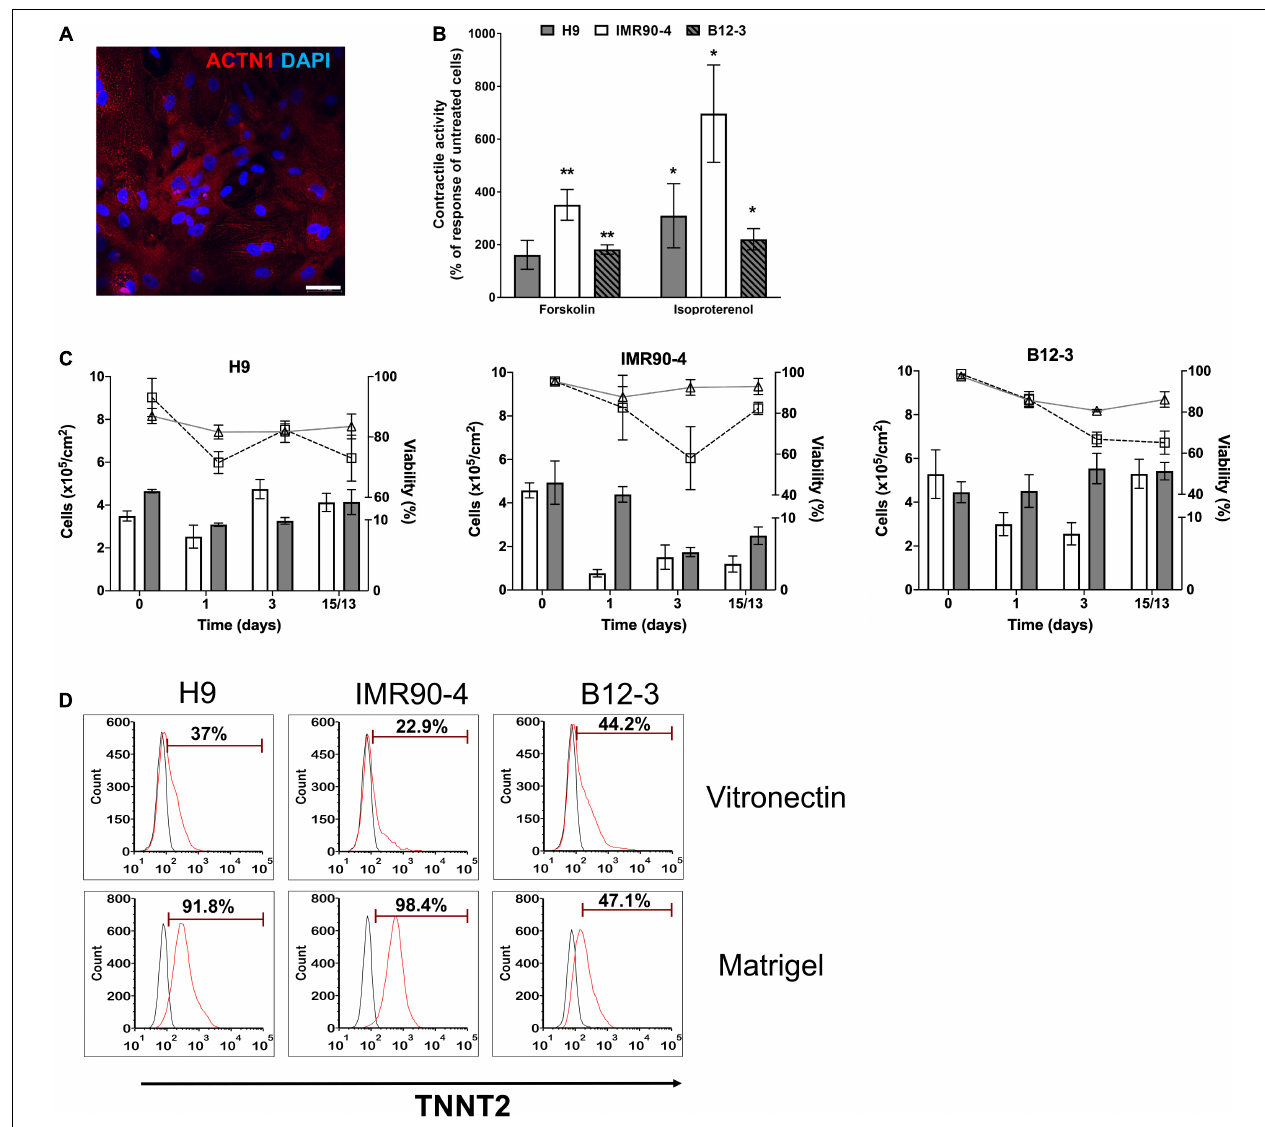
FIGURE 3 | Human PSC-derived CMs in planar culture. (A) Immunostaining of differentiated B12-3 cells for ACTN1. Bars: 50 µ m. (B) Contractile activity of generated CMs in response to forskolin or isoproterenol. * p < 0.05, ** p < 0.01 vs. untreated cells. (C) Comparison of the number of live cells and viability between the XF protocol developed here (cell number: gray bars; viability: triangles/solid lines) and GW protocol (cell number: white bars; viability: squares/dashed lines) (Lian et al., 2013a). Day 0 denotes the start of the differentiation. (D) Flow cytometry data depicting the fractions of TNNT2 + cells produced with the GW protocol (day 13) on vitronectin (top row) and Matrigel (bottom